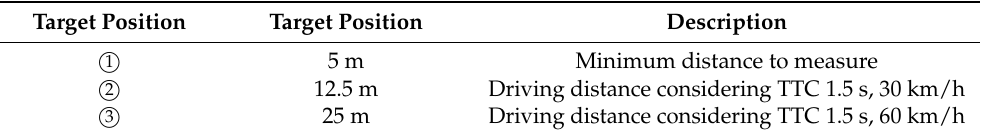
Figure 6. Pedestrian target position.